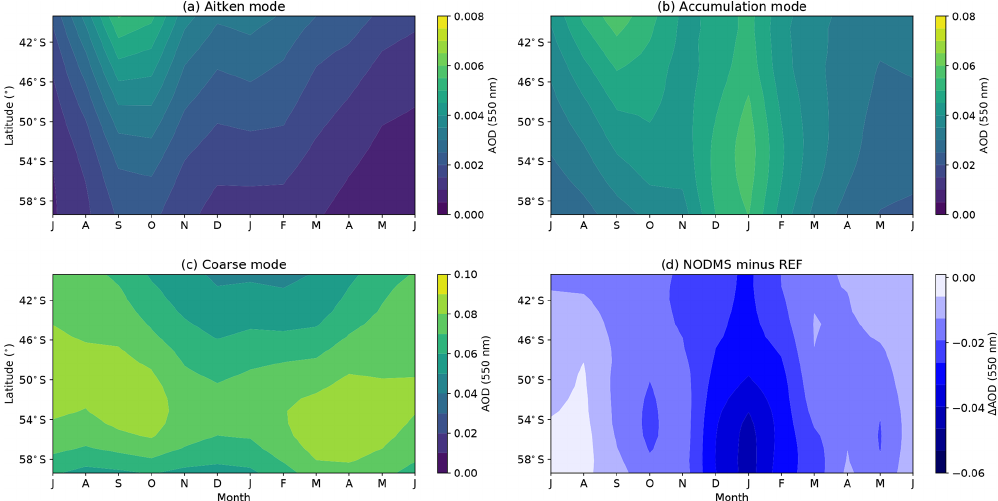
Figure 2. (a) Monthly climatological zonal-mean contribution to AOD at 550nm from soluble Aitken-mode AOD in the REF simulation performed with HadGEM3-GA7.1-mod. (b) As for panel (a) but showing accumulation-mode AOD. (c) As for panel (a) but showing coarse- mode AOD. (d) Difference in climatological monthly-mean AOD between the REF simulation and NODMS simulation with surface DMS emissions switched